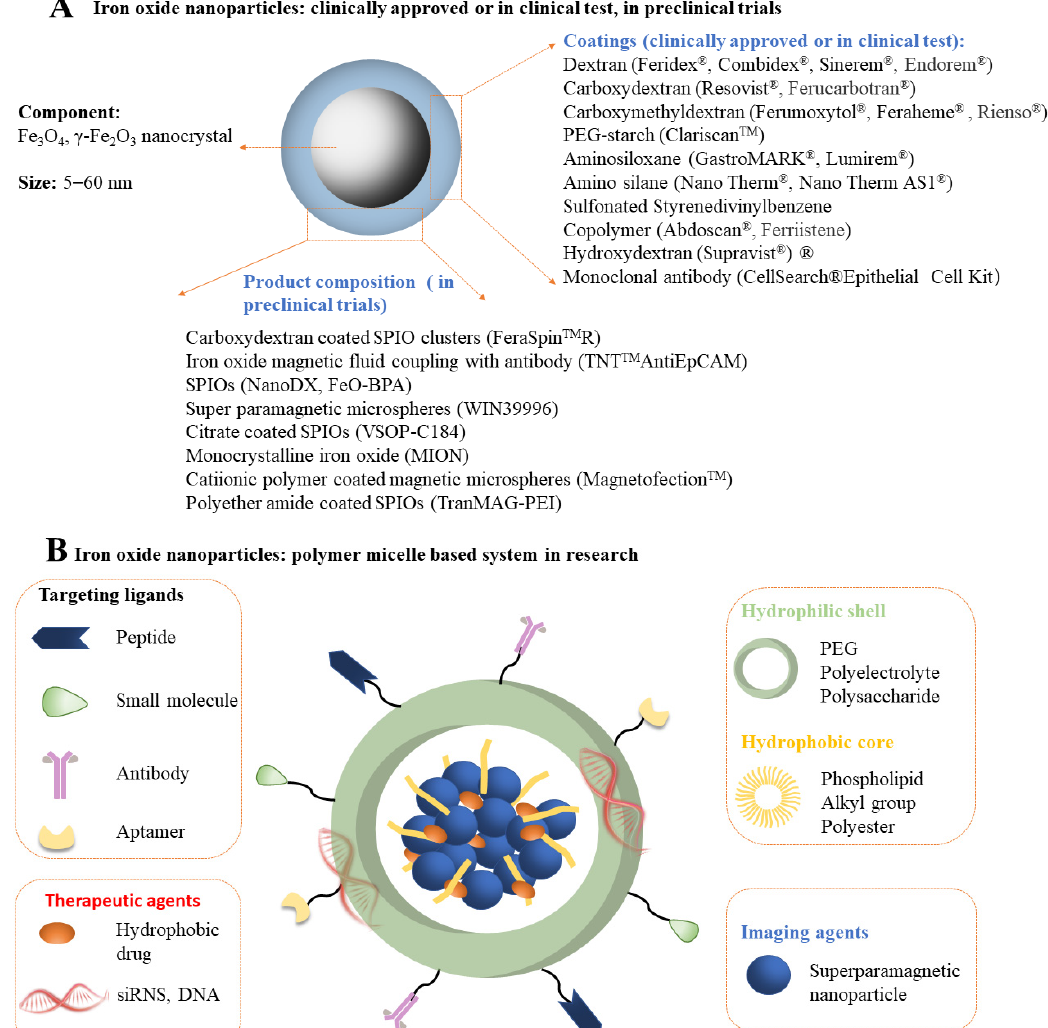
Figure 2. ( A ) Iron oxide nanoparticles (IONPs) approved or in (pre-) clinical trials [27,31]; the coating material is listed on the left, and the commercial product name is shown in the brackets on the right. SPIOs: super paramagnetic iron oxides. ( B ) IONPs: polymer micelle-based system in research.